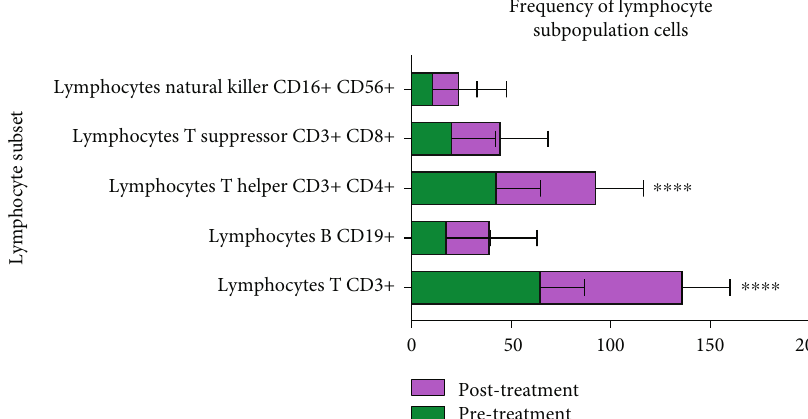
Figure 5: Graphical representation of lymphocyte subsets before and after treatment. Data are expressed as the mean ± standard deviation (SD). Di ff erences in CD3+ lymphocytes and CD3+ and CD4+ T helper cells were considered statistically signi fi cant relative to the pretreatment group. ∗∗∗∗ p < 0 : 0001 , pre- vs. Table 4: Patients who experienced adverse events after Parvulan injection. Number (percentage) of patients with adverse events after treatment.